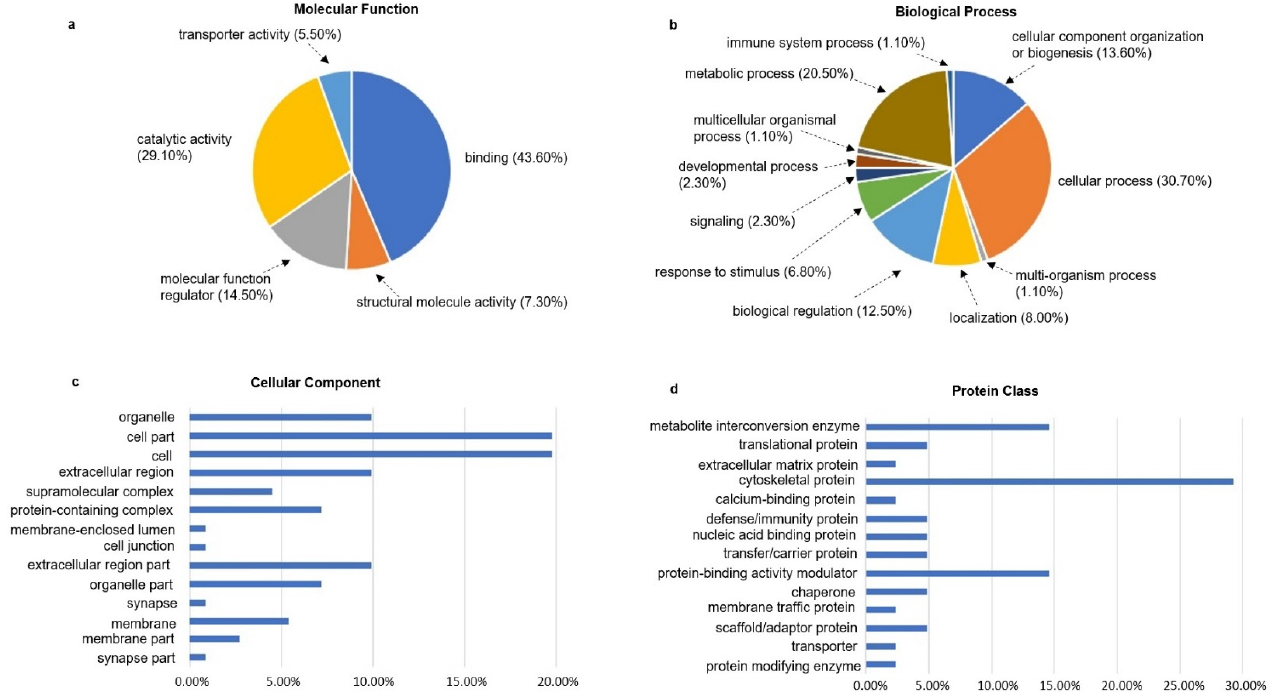
Figure 4. Gene ontology analysis of the ischemia-associated ncAA-containing proteins. The ischemia-associated ncAA-containing proteins (R 2 > 0.5, ratio > 2-fold, p < 0.05) were categorized using the PANTHER database. ( a ) Molecular function; ( b ) biological process; ( c ) cellular component; ( d ) protein class. Each percentage number indicates the percentage of gene hits classified to each category out of the total number of molecular function/biological process/cellular component/protein class hits.